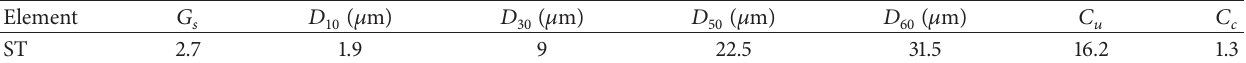
Table 2: Physical characteristics of STs.